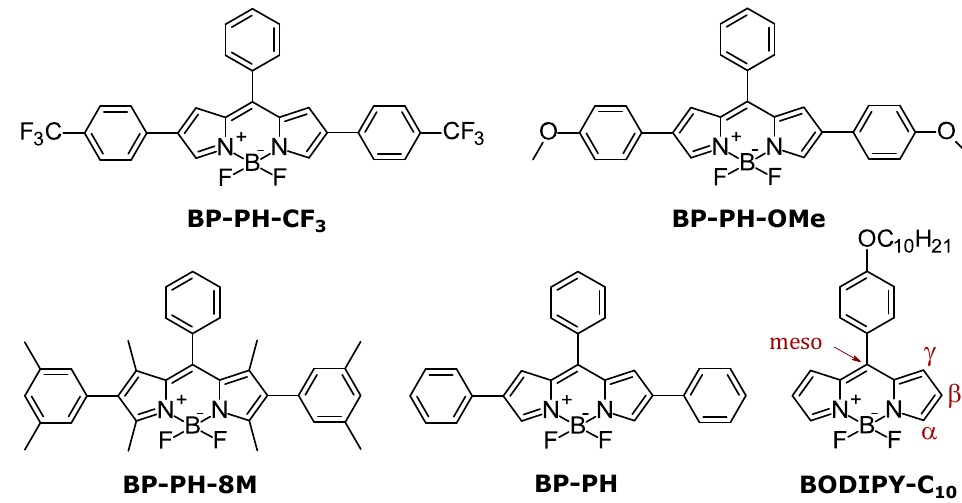
Figure 1. Molecular structures of BODIPYs investigated in this research (BP-PH-CF 3 , BP-PH-OMe, BP- PH-8M) together with previously reported BP-PH [33] and a well-known viscosity probe BODIPY-C 10